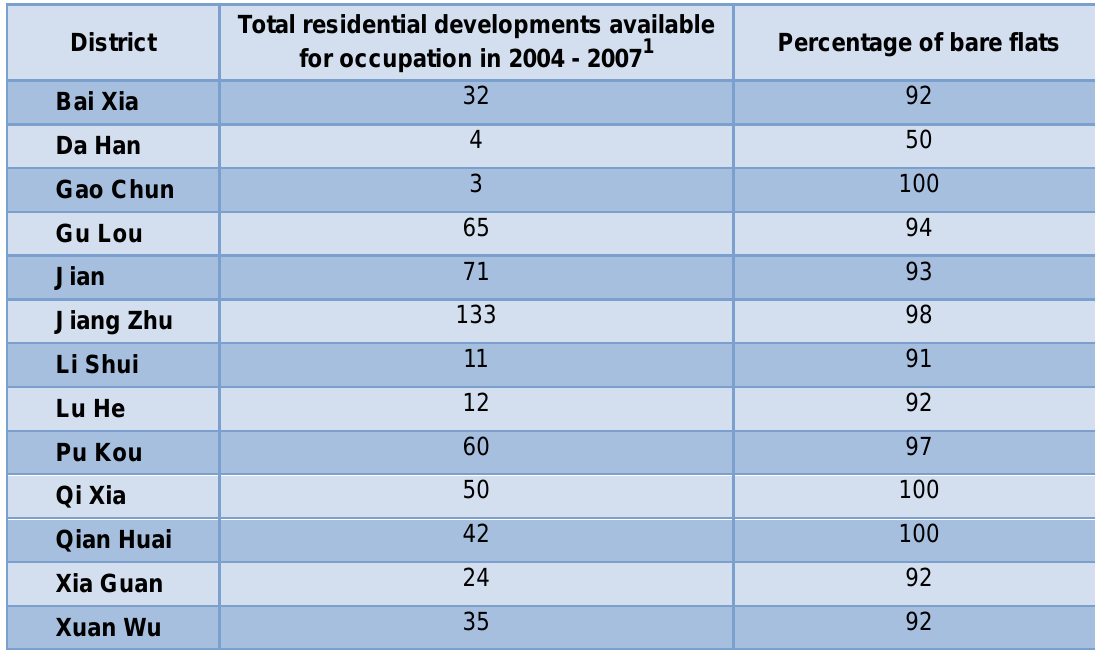
Table 1 Percentage of bare residential units in Nanjing (Li, 2010)